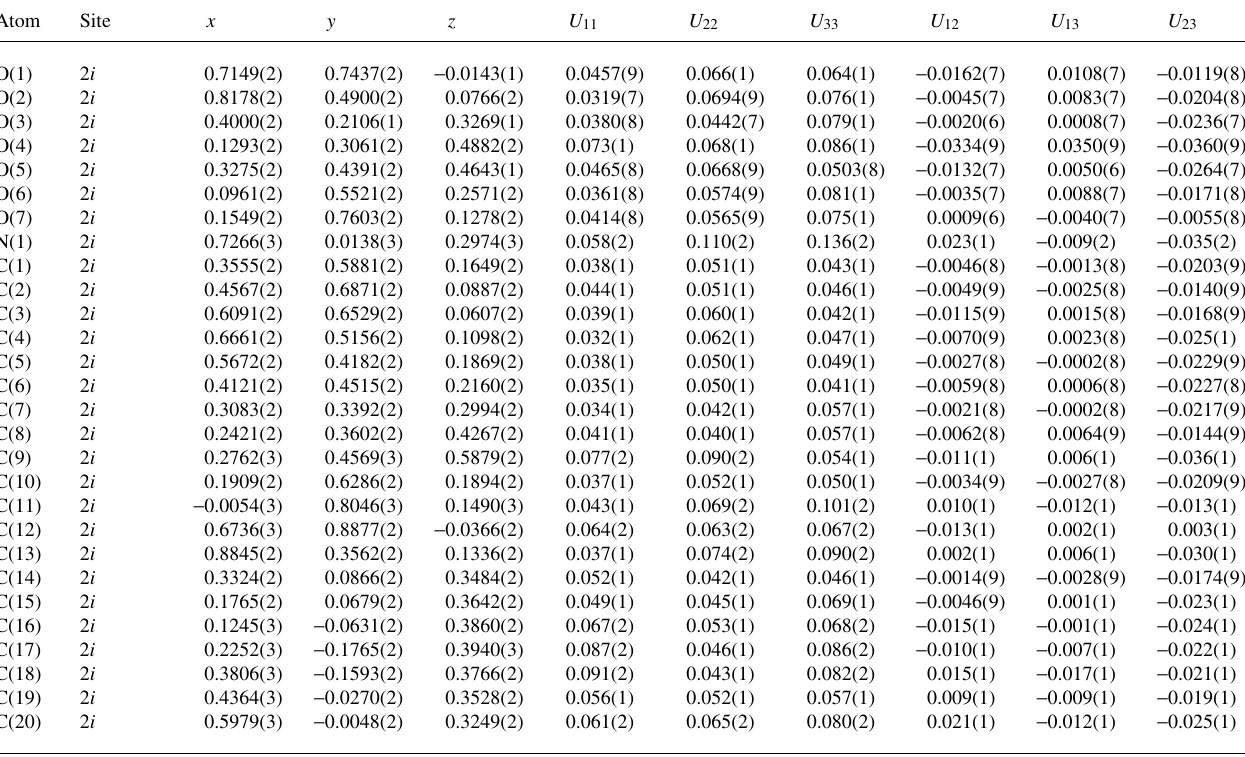
Table 3. Atomic coordinates and displacement parameters (in Å 2 )